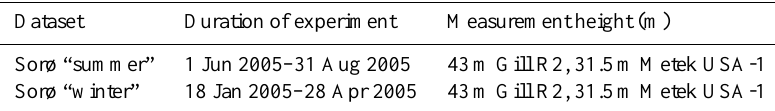
Table2. Verticalwindparametersevaluatedfor T =1800sfromtheSolentR210Hzdataforwesterlywinddirections. L = U T (seeEq4) istheintegrallengthscale.